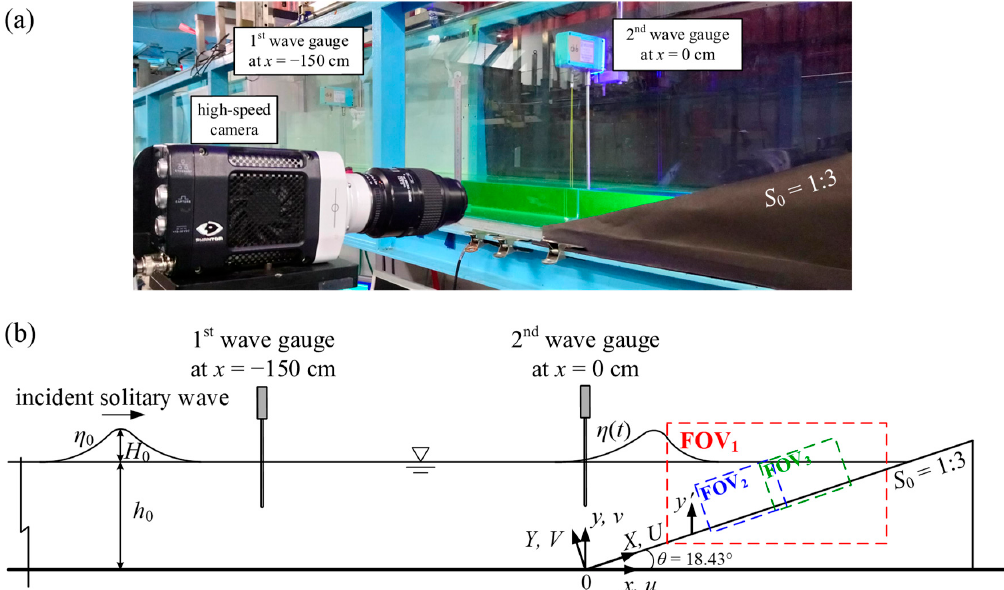
Figure 1. ( a ) A photo showing the wave flume along with the sloping beach, two wave gauges and the high-speed camera; ( b ) Schematic diagram indicating the sloping beach model and two coordinate systems, together with installation of the two wave gauges at x = − 150.0 and 0 cm and deployment of three fields of view, FOV 1 –FOV 3 , for HSPIV measurements.